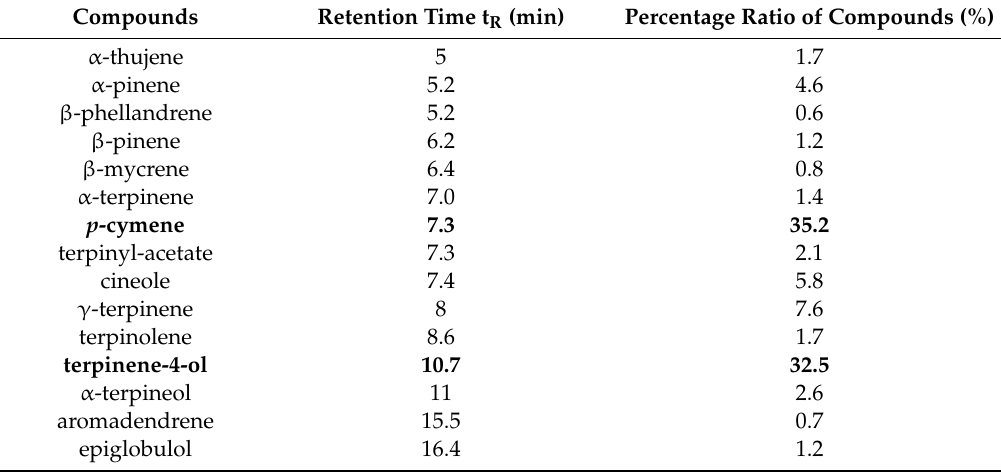
Table 2. Composition of Melaleuca alternifolia EO. The results of GC analysis showed the average of the two parallel measurements in the percentage of volatile compounds. The main components of MA have been